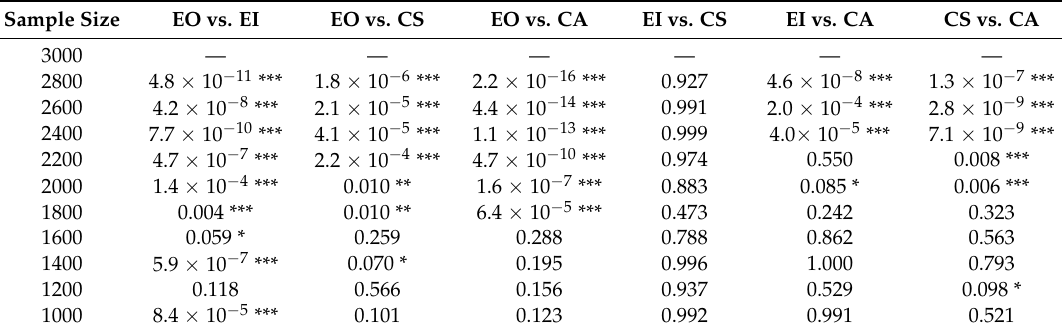
Table 7. T -test results for significance in method pairwise differences based on mean AUC values with reduced sample sizes ( p -value shown, * for significance at α = 0.10, ** at α = 0.05, and *** at α = 0.01). Sample